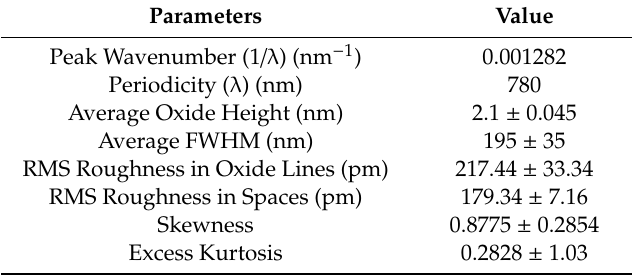
Figure 8. ( a , b ) Atomic force microscope (AFM) topography image of the oxide lines made by R-NEL. ( c ) Power spectral density (PSD) of the AFM image shown in ( b ). ( d ) Profile of the lines marked in the image ( b ). Table 1. Metrological characteristics of the silicon surface after the NEL